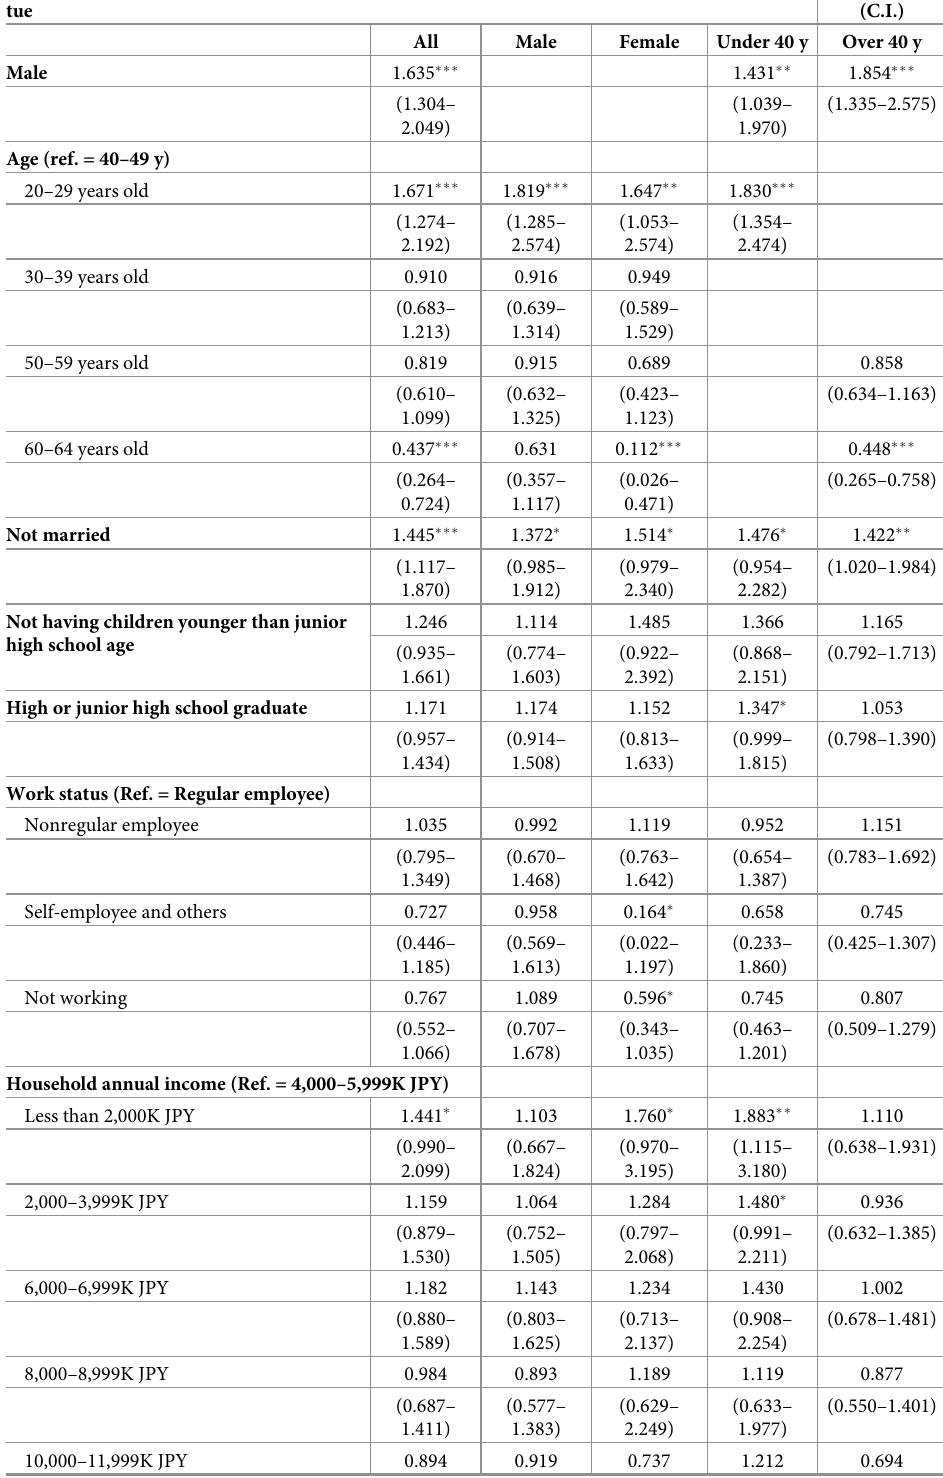
Table 4. Estimation results of multivariate logit model for not conducting social distancing. Dependent variable: Avoid places where items 1–3 above overlap in Table 2 - > Not at all or not tue